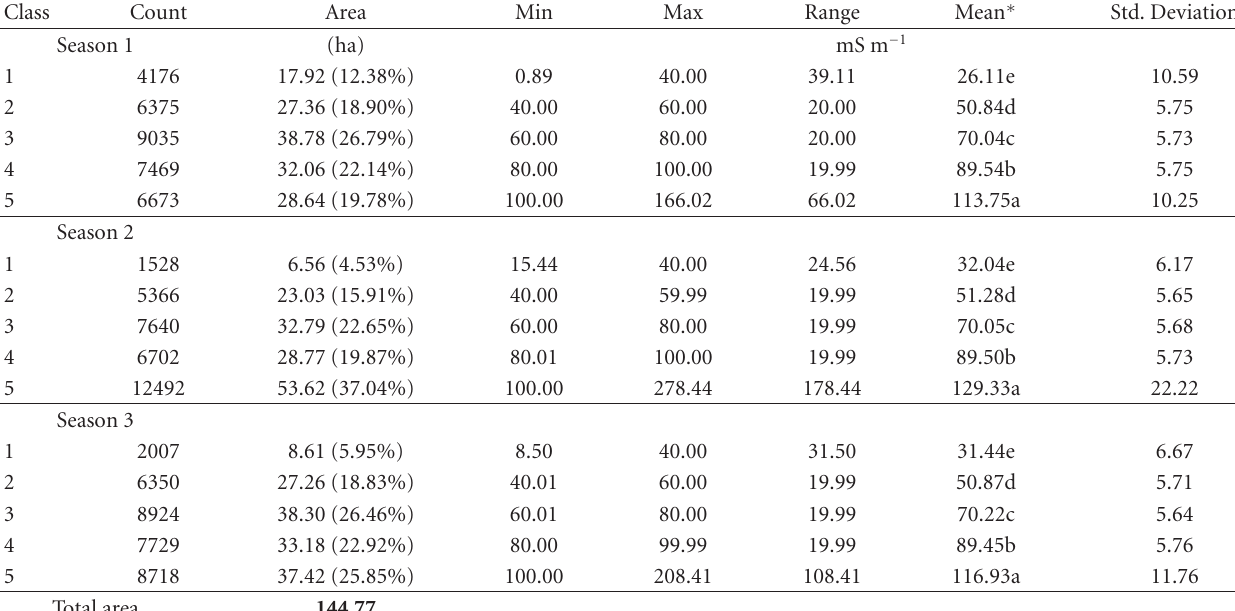
Table 2: Summary of kriged deep EC a maps for three seasons classified by smart quantiles.